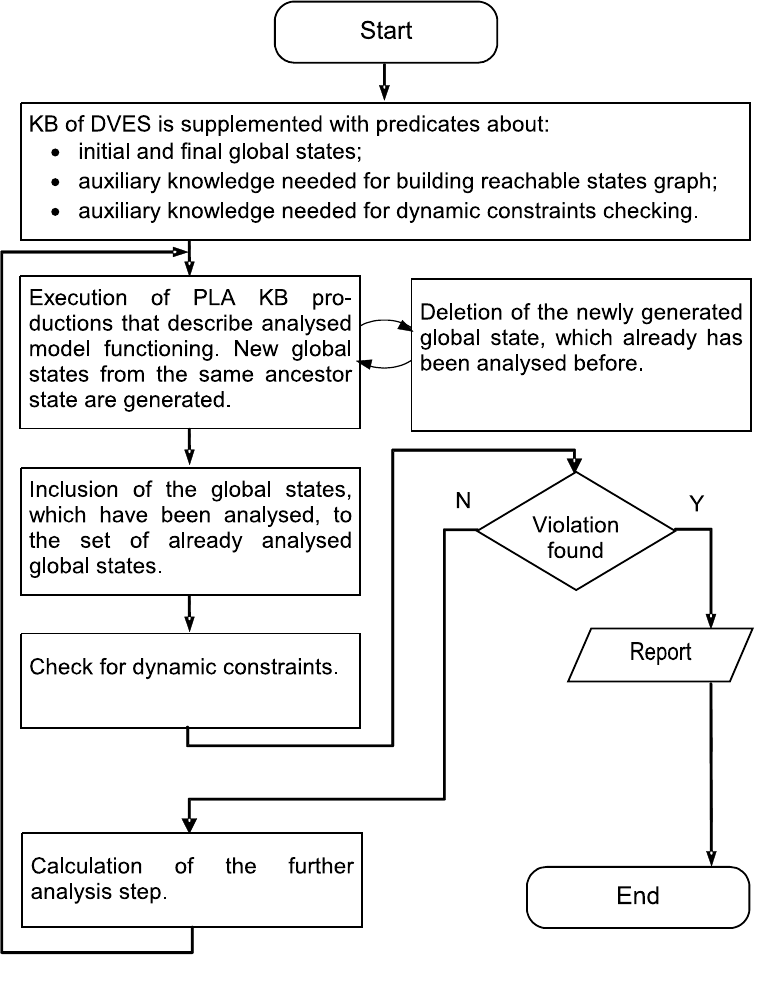
fig. 1. Dynamic validation